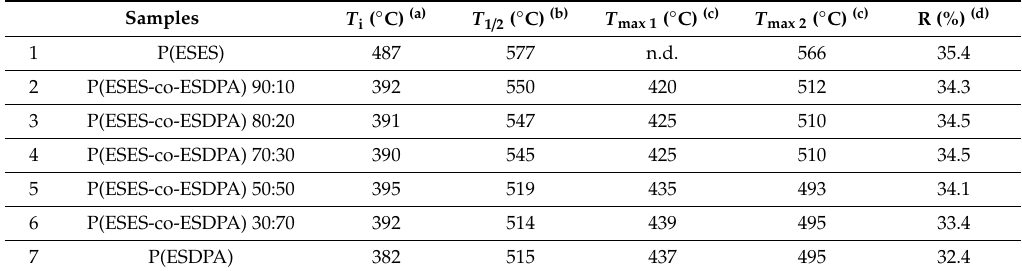
Table 1. Thermogravimetric data of the P(ESES-co-ESDPA) copolymers and the corresponding